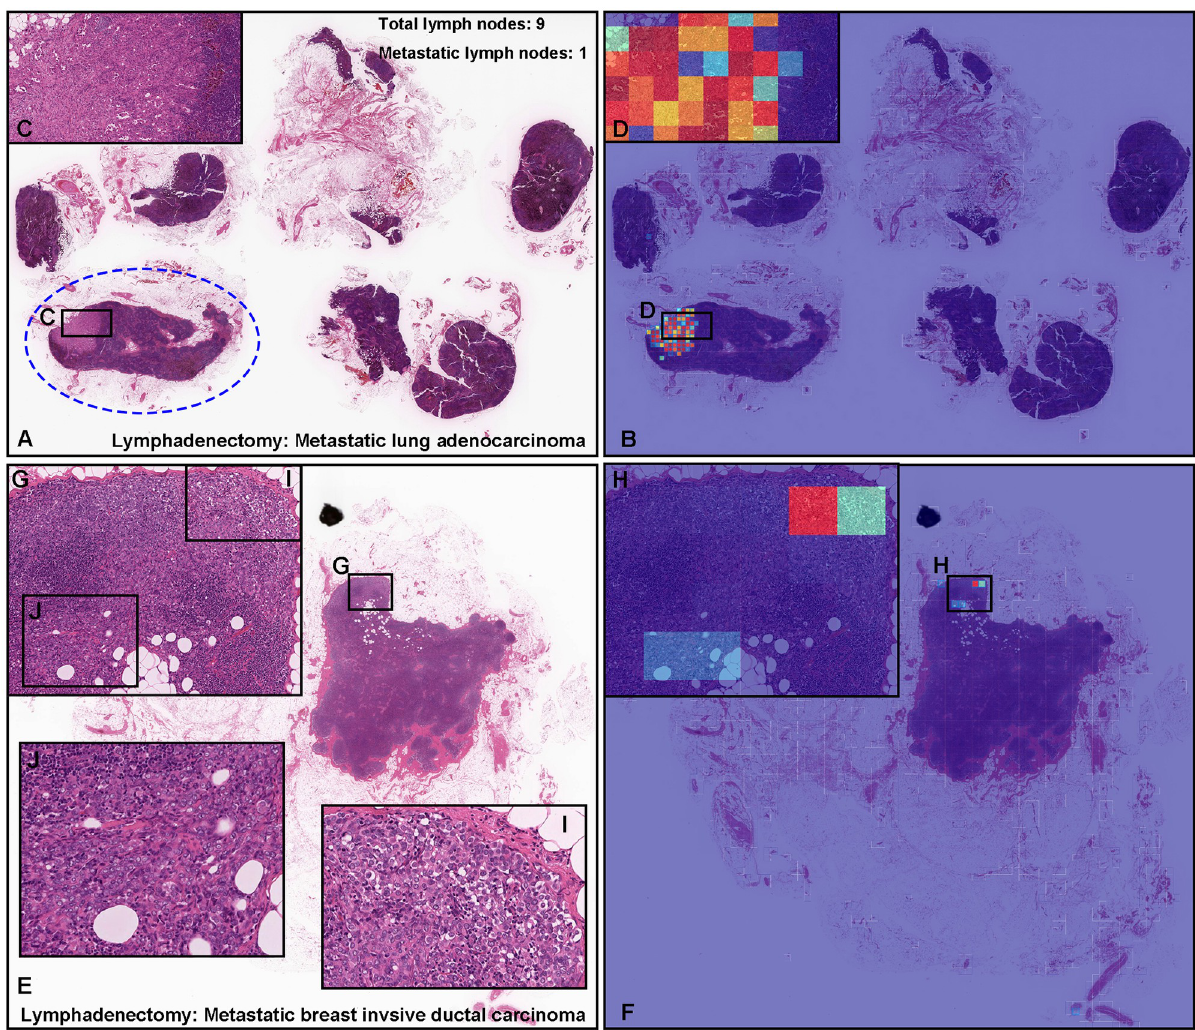
Fig 4. Representative examples of metastatic adenocarcinoma true positive prediction outputs on cases from radical lymph node dissection (lymphadenectomy) test sets using the model (WS-4K: 224, x10 EfficientNetB1). In the metastatic lung adenocarcinoma (A) and breast invasive ductal carcinoma (E) whole slide images (WSIs) of radical lymph node dissection specimens, the heatmap images show true positive prediction of metastatic lung adenocarcinoma (B, D) and breast invasive ductal carcinoma (F, H) cells which correspond respectively to H&E histopathology (A, C, E, G, I, J). According to the histopathological diagnostic report, in (A), only one lymph node (blue dot line circled) was positive for metastatic lung adenocarcinoma (C). The heatmap image (B) shows true positive prediction which was consistent with areas of metastatic lung adenocarcinoma invasion in the same lymph node (D). The heatmap image (B) also shows no positive predictions in the lymph nodes without evidence of cancer metastasis (A). As compared to (A), histopathologically, it was not easy to determine metastatic cancer areas in (E) at low power view. According to the histopathological report, in (E), metastatic breast invasive ductal carcinoma was localized in (G). The heatmap image (F) shows true positive predictions in (H) which are coincided with metastatic carcinoma infiltrating areas (G, I, J). The heatmap uses the jet color map where blue indicates low probability and red indicates high